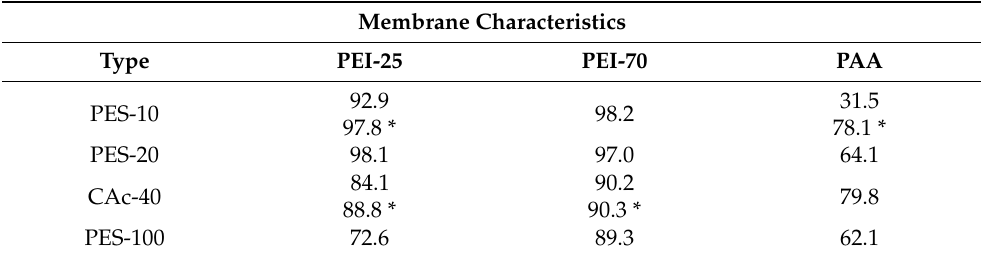
Table 4. Ni retention (%) measure for different CA-membrane